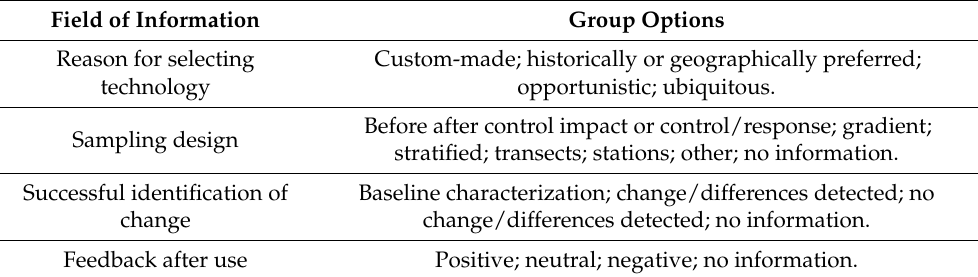
Table 2. Group options for each field for which the information was synthesized across